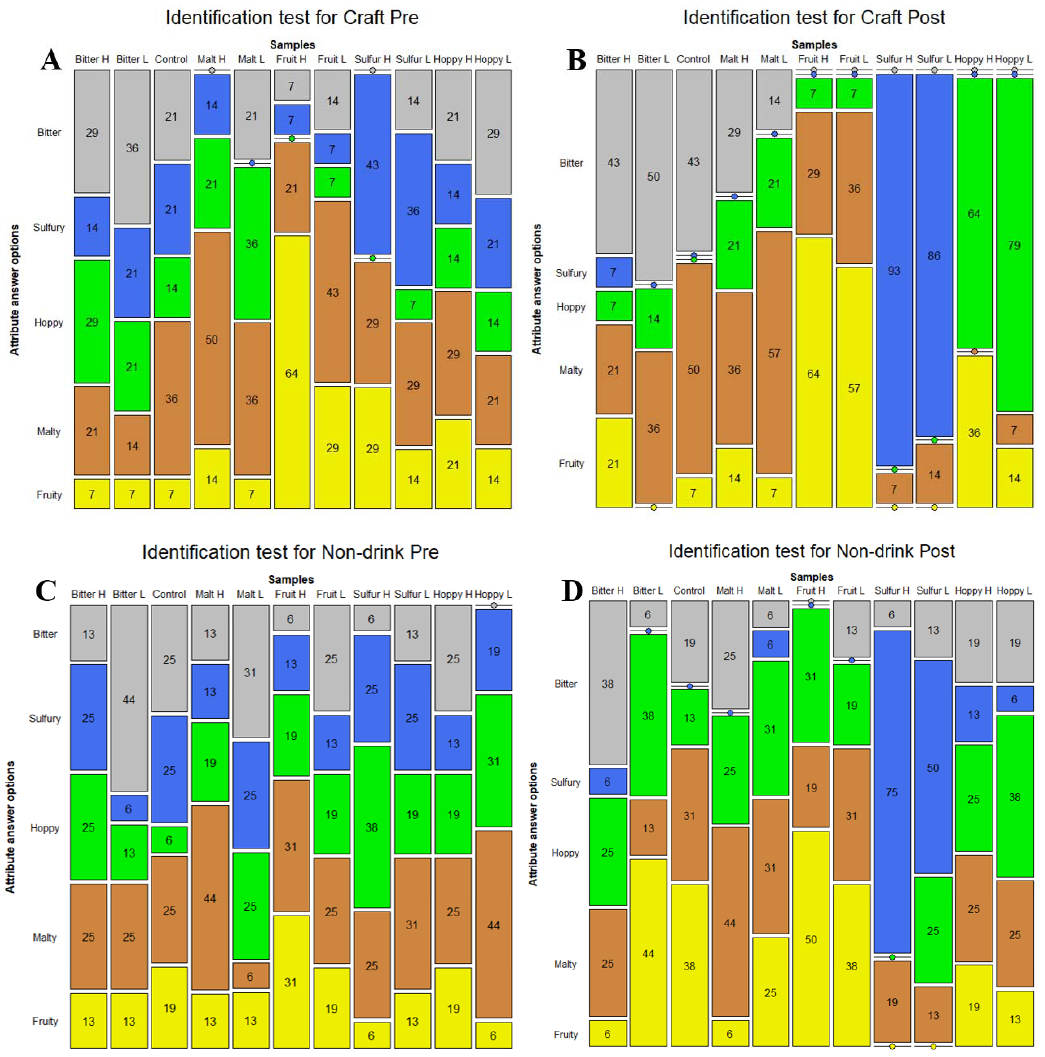
Figure 3. Mosaic plot for percentages of replies during the identification test with an attribute list. The color codes are as follows: grey = bitter, blue = sulfury, green = hoppy, brown = malty, and yellow = fruity.